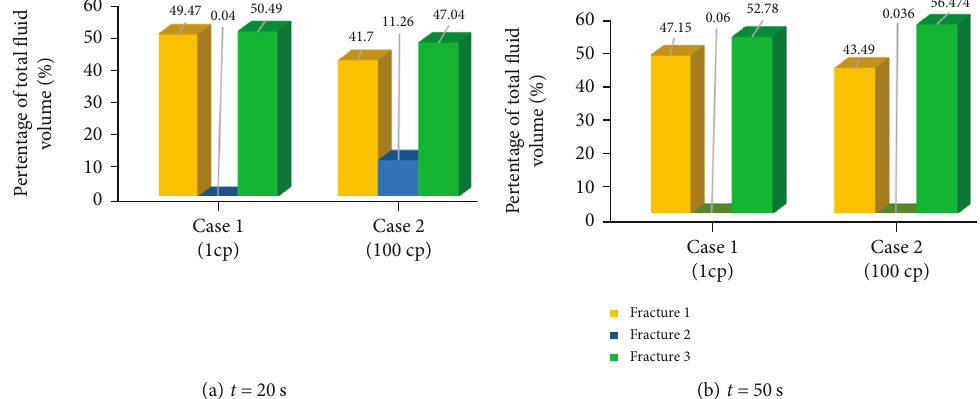
Figure 13: The total fl uid volume distribution of each cluster after pumping for 20 s and 50s for two di ff erent fracturing fl uid